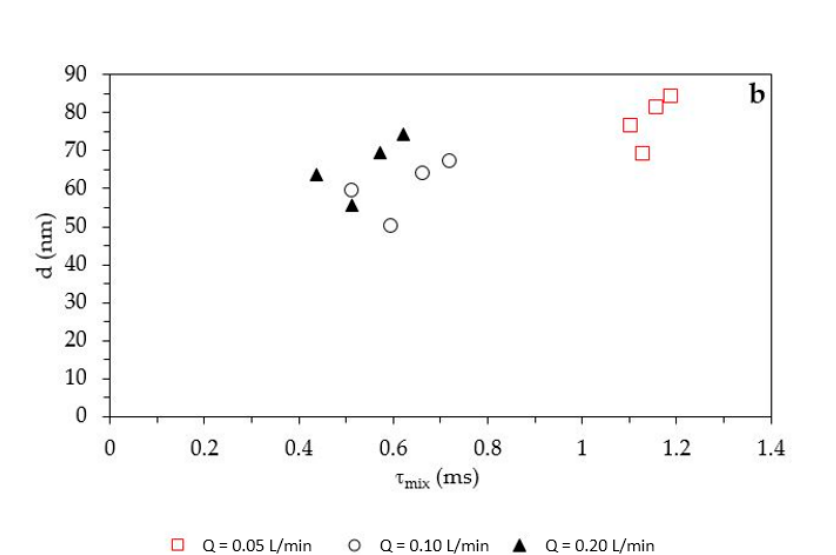
Figure 6. d trend with respect to ε ( a ) and τ mix ( b ).